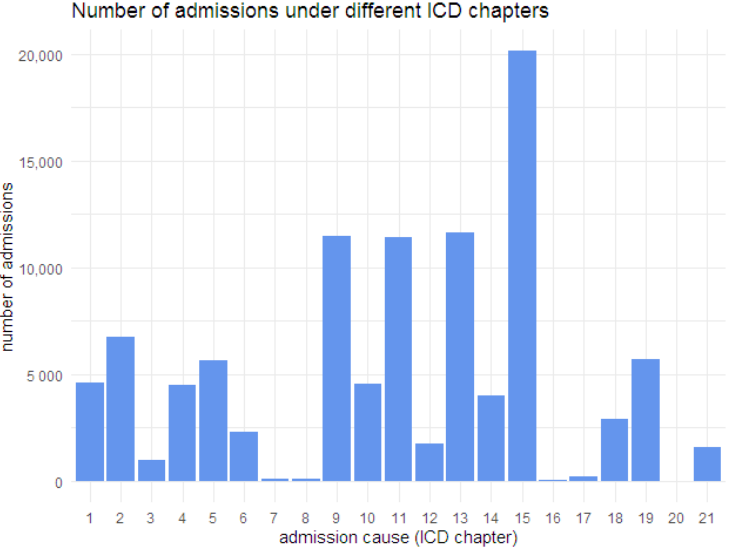
Figure 1. Distribution of admissions over different ICD chapters (details about chapters in Table